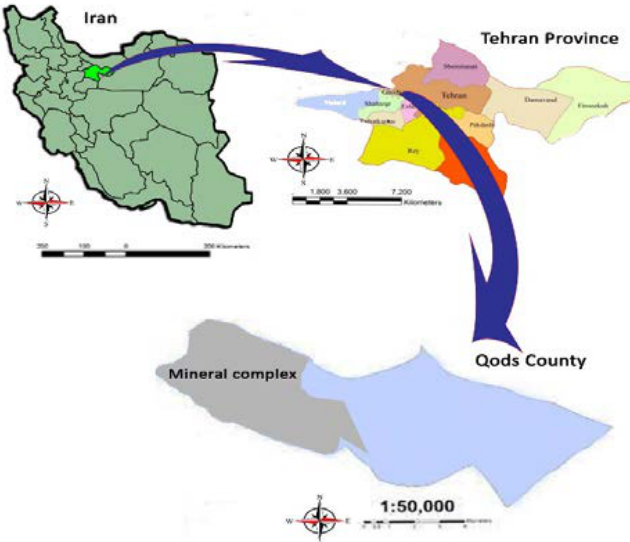
Fig. 1: Geographic location of the study area in Shahre Qods in the southwest of Tehran, Iran